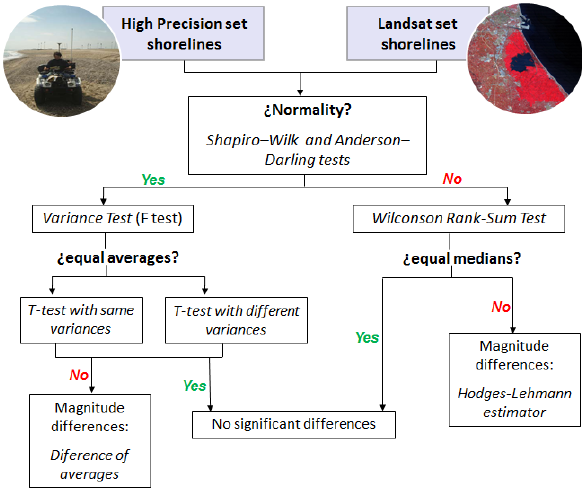
Figure 5. Methodological framework. Comparison process between annual average or median shorelines obtained from Landsat and high precision data.